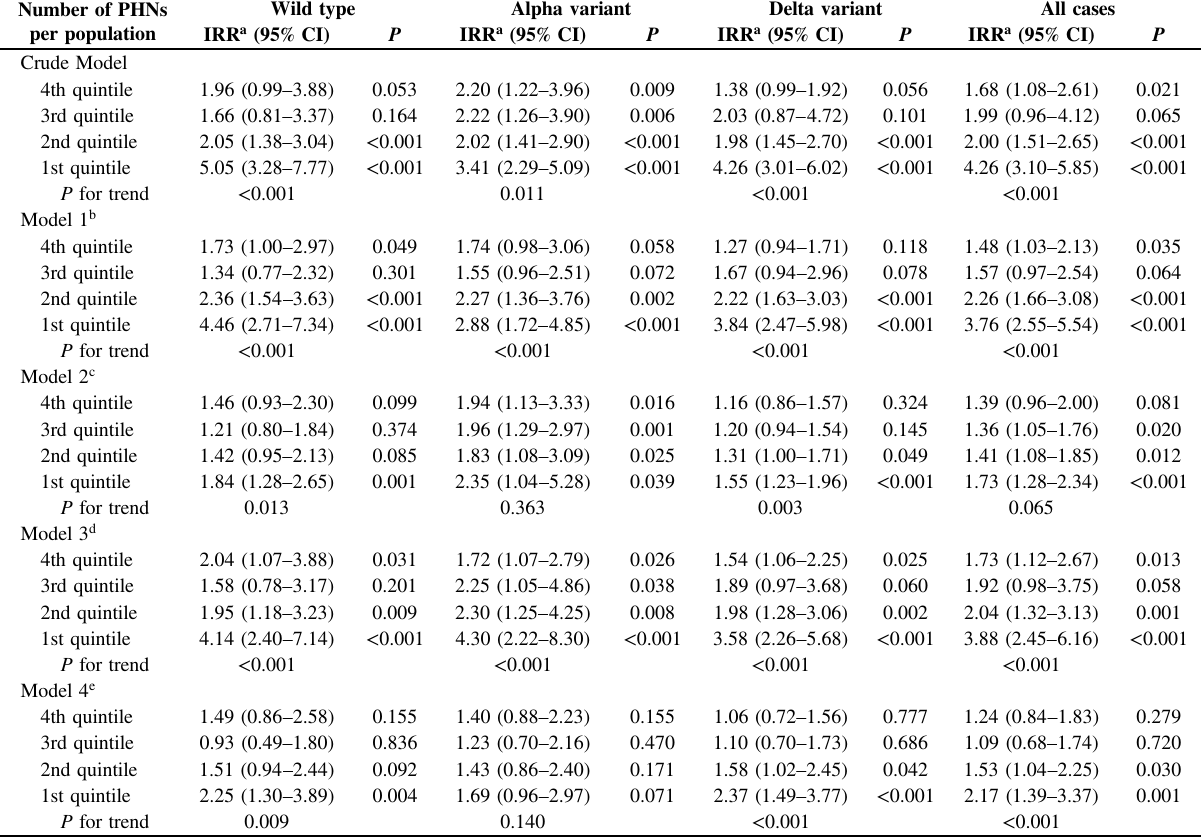
Table 1 Association between COVID-19 incidence rate and number of PHNs per population, by variant type Wild Number of PHNs per population